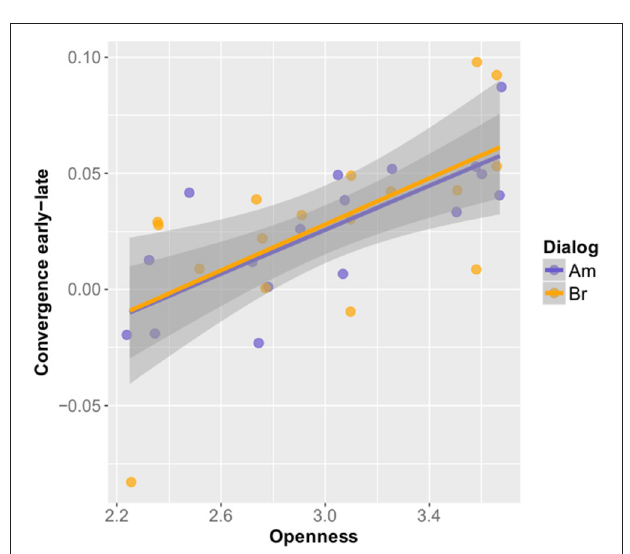
FIGURE 3 | Openness and phonetic convergence with color-coded native speaker